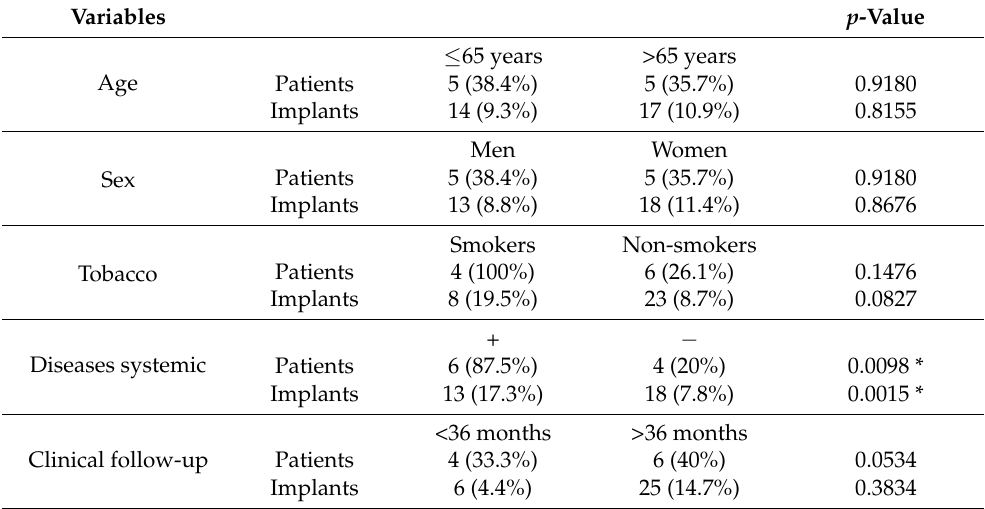
Table 7. Distribution of patients ( n = 10) and implants ( n = 31) with